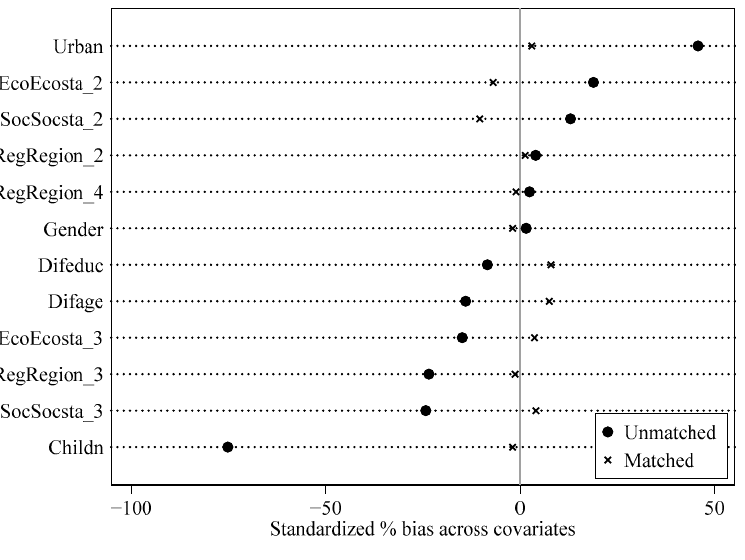
Figure 4. Balancing test.